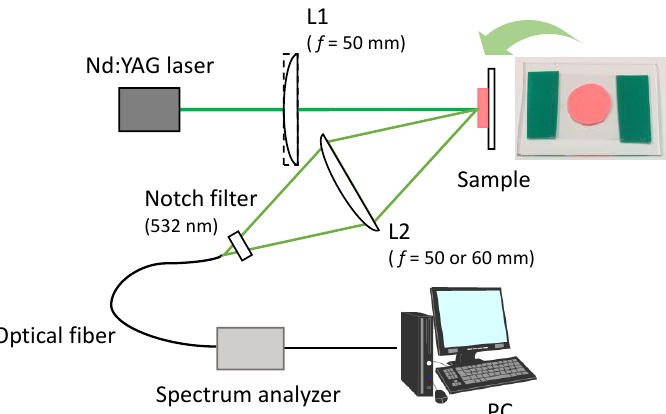
Figure 2. Schematic of the experimental setup for measuring random laser (RL) emission. L1 indicates a plano-convex lens or a plano-convex cylindrical lens, and L2 indicates a plano-convex lens.